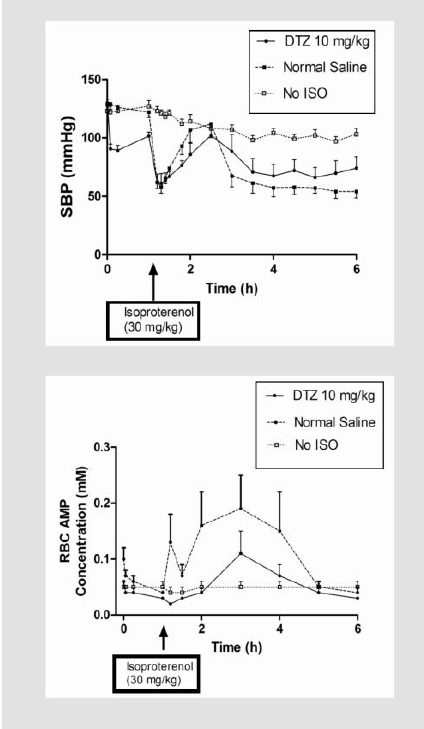
Figure 6. Effect of diltiazem (DTZ) on systolic blood pressure (SBP) ( top ) and RBC concentrations of AMP ( bottom ). Each point represents mean ± SEM. (Abbreviations: No ISO = No isoproterenol).